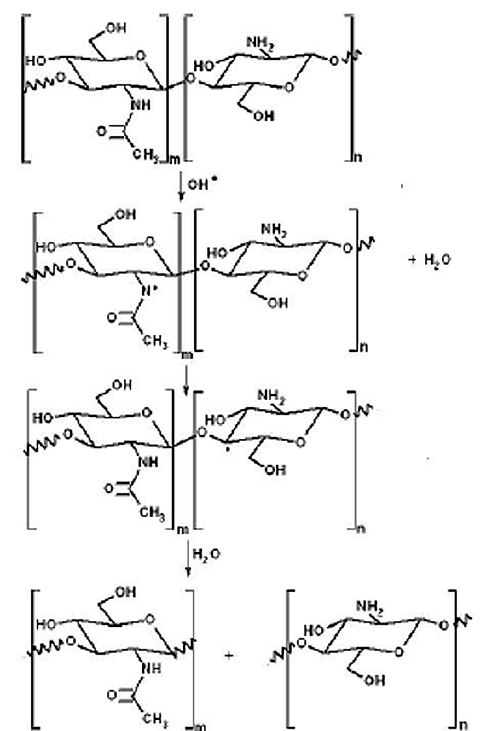
Figure 11. The scheme of chitin degradation under hydroxyl radical action in the EBP: the attack of OH radicals on the chitin –NH 2 groups.